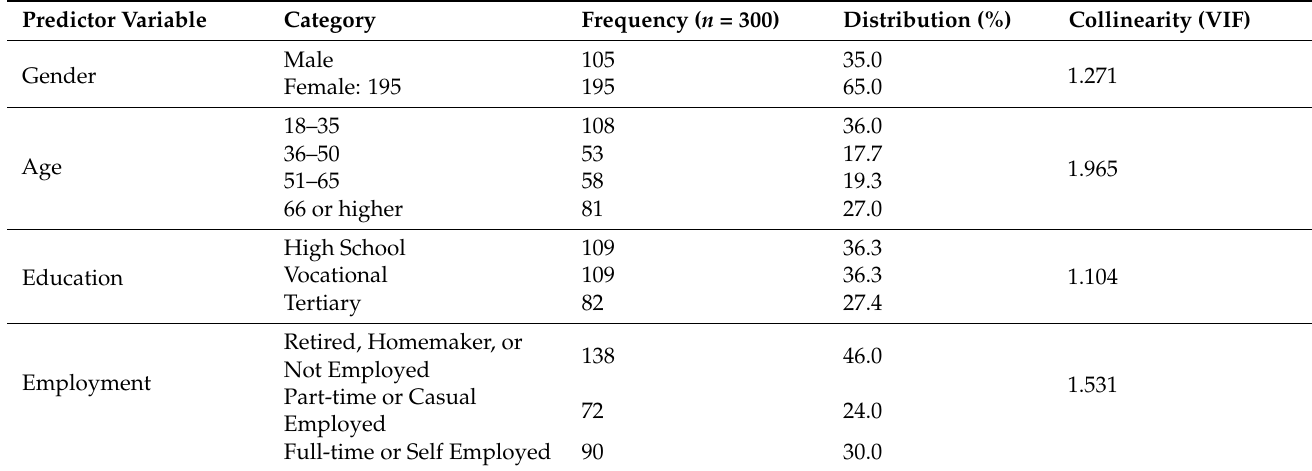
Table 3. Demographic attributes and collinearity tolerances of predictor